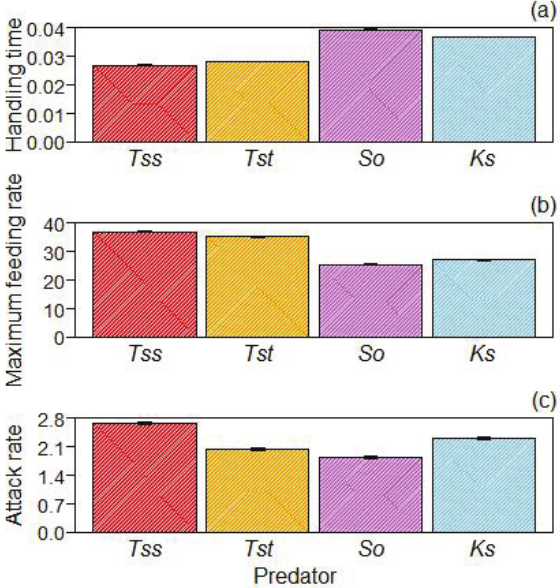
Figure 2. Parameter estimates ( ± SE) of: a handling time h b maximum feeding rate 1/ h c attack rate a , for bootstrapped ( n = 30) Type II functional response curves of T. s. scripta (Tss), T. s. troostii (Tst), S. odoratus (So) and K. subrubrum (Ks) towards G. pulex prey. Table 3. Impact Potential (IP) and Invasion Risk (IR) calculations, whereby: IP(FR) = Maximum feed- ing rate (FR) × NRproxy i.e. lifespan (L), fecundity (F) or lifetime fecundity (LF); IP( a ) = Attack rate ( a ) × NRproxy; IR(FR) = IP(FR) × Pet Propagule Pressure (PPP); IR( a ) = IP( a ) × PPP. PPP (Northern NI Ireland) is a function of the proportional availability of each species across pet shops and the total number of pet shops surveyed and PPP (Great Britain) is the proportional availability of the four species based GB on online advertisements and the total number of advertisements